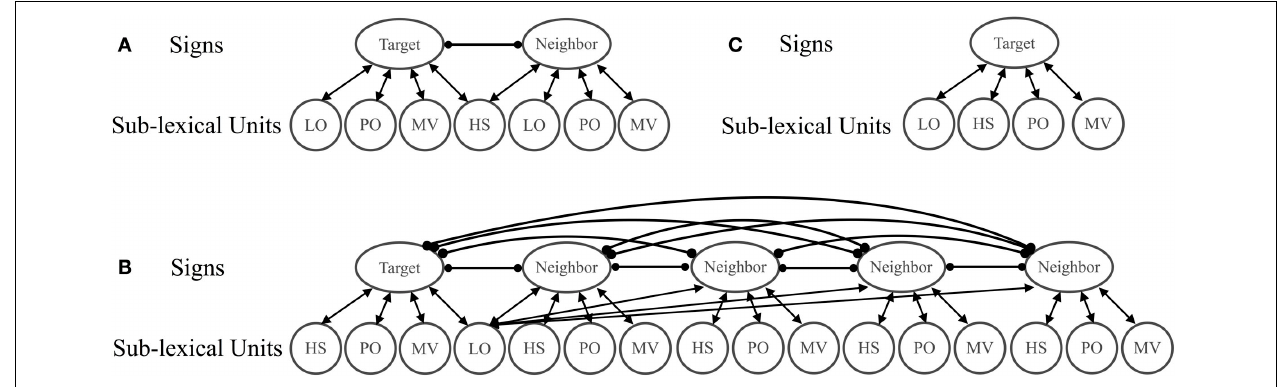
FIGURE 5 | Architecture of sign perception when Neighbor Type was manipulated by varying the number of neighbors. Activation of the target with a handshape neighbor (A) or location neighbor (B) was compared to